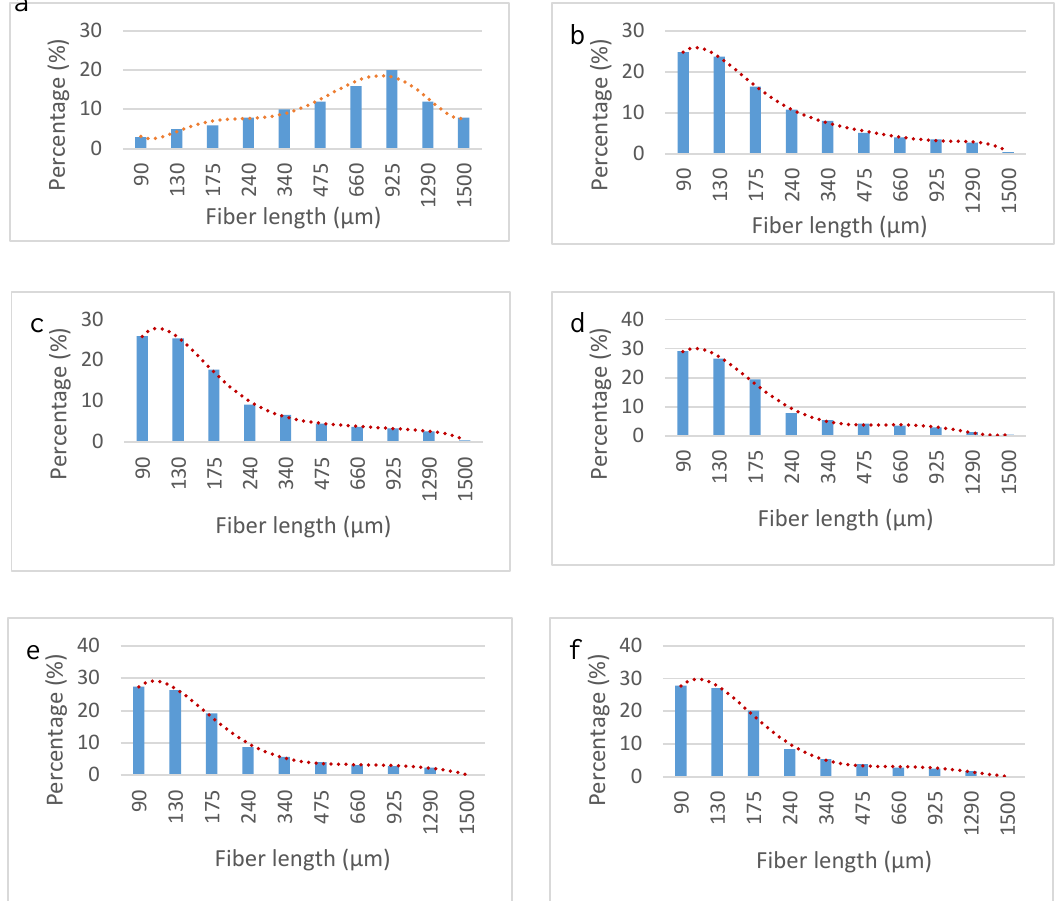
Figure 6. Fiber length distributions for the CSF; ( a ): Initial fibers, ( b ): 10 wt. % CSF, ( c ): 20 wt. %, ( d ): 30 wt. %: ( e ) 40 wt. %, ( f ): 50 wt. %.